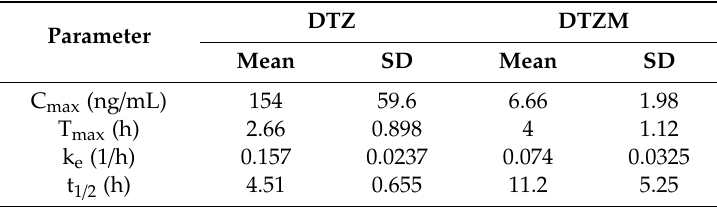
Table 3. Summary pharmacokinetic parameters of DTZ and DTZM in healthy subjects estimated by non-compartmental analysis.